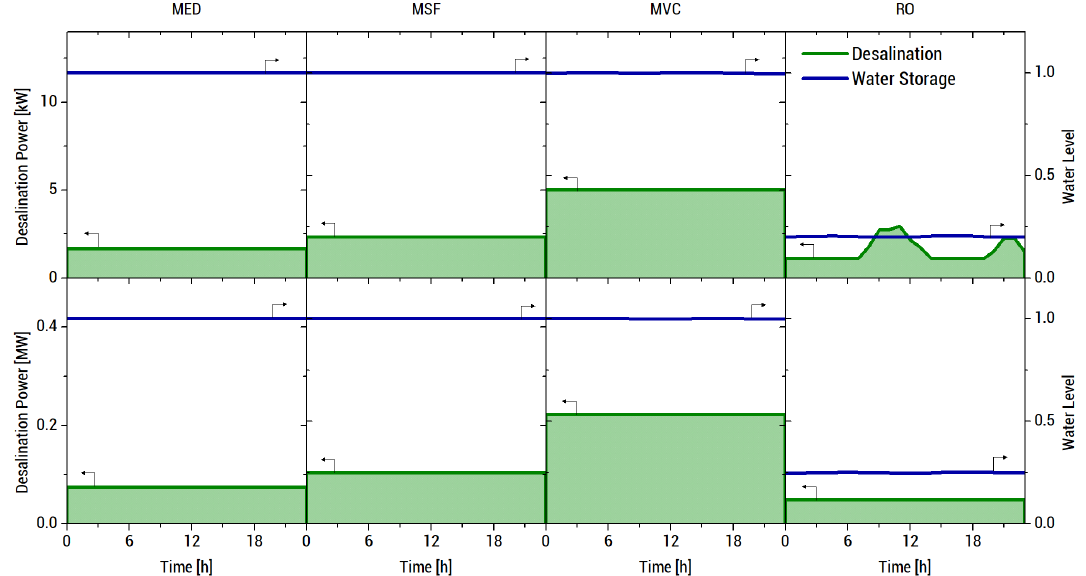
Figure 12. Hourly desalination energy consumption and water storage fraction on Camasusu Island ( top ) and Lubang Island ( bottom ). Power consumption is uneven in the RO system on Camasusu Island.